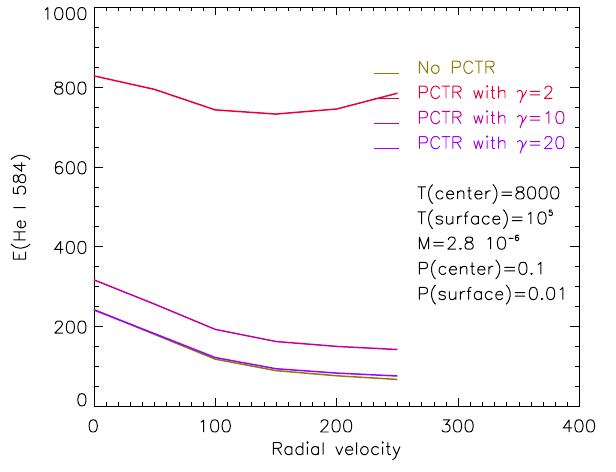
Fig. 4. Variation of the hydrogen H α line intensity (in − 1 ergs − 1 cm − 2 sr − 1 ˚A ) as a function of the radial velocity of the prominence plasma (in kms − 1 ) for 4 different types of prominence